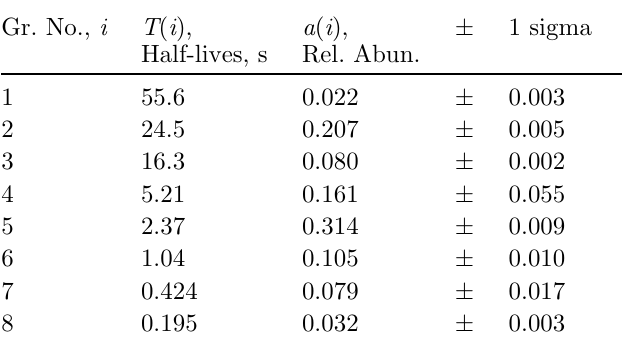
Table 1. The recommended data set of the 8-group DN parameters for fi ssion of 240 Pu by fast neutrons expanded from the 6-group model (the LANL expansion method [3]). The LANL expansion method. Pu-240_fast: